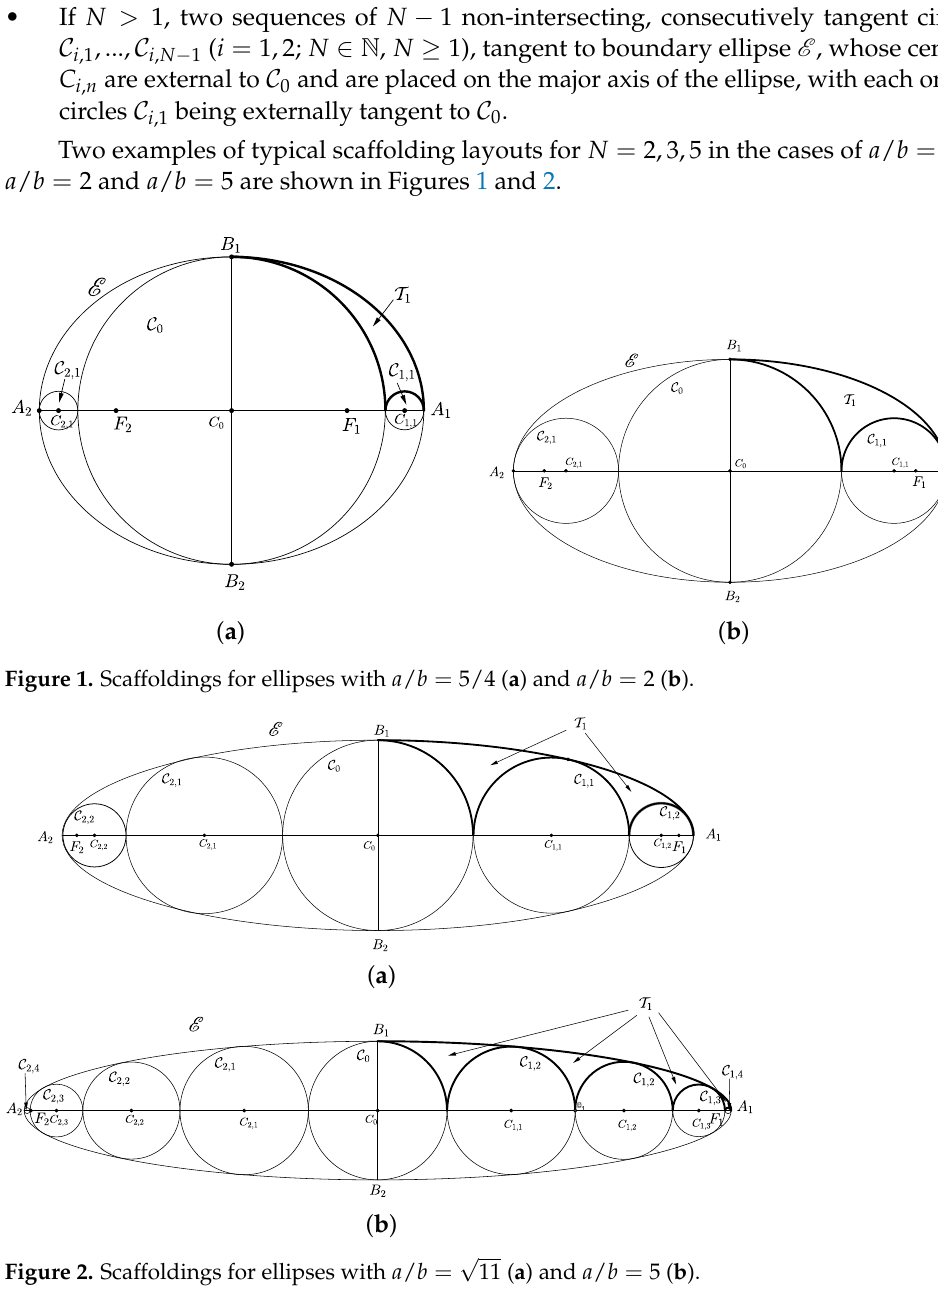
Figure 2. Scaffoldings for ellipses with a / b =